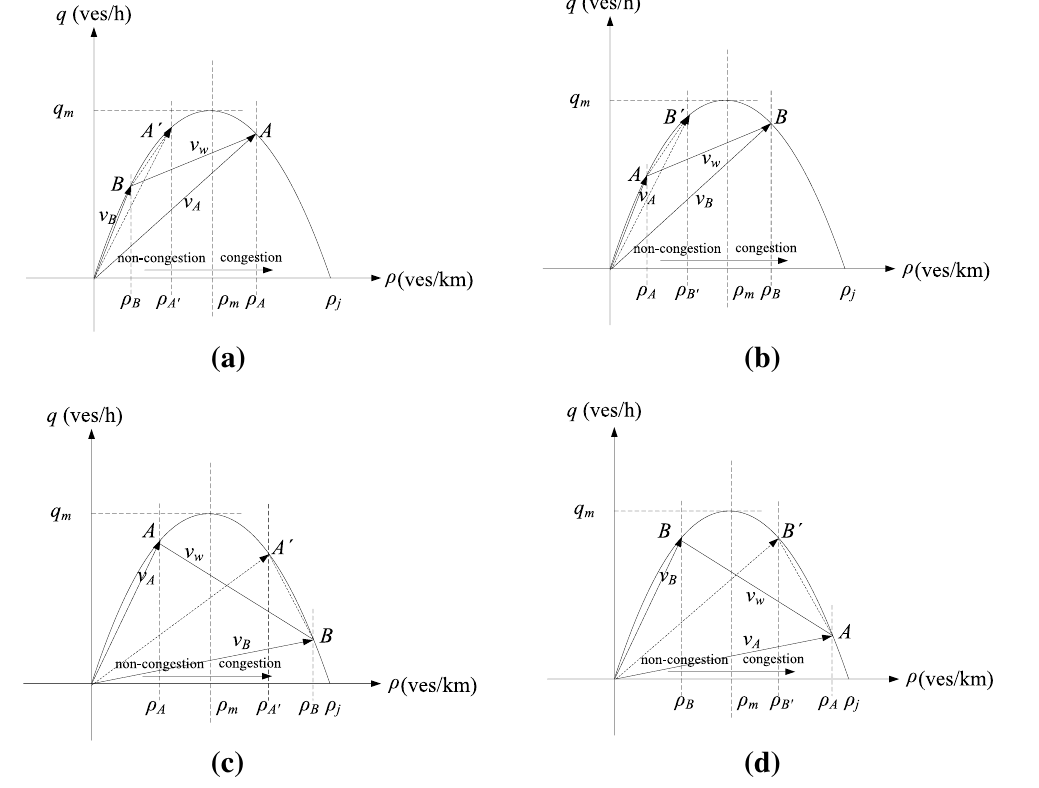
Fig. 3 The relationship between traffic flow rate and density in different cases. a The first case when v The first case when v